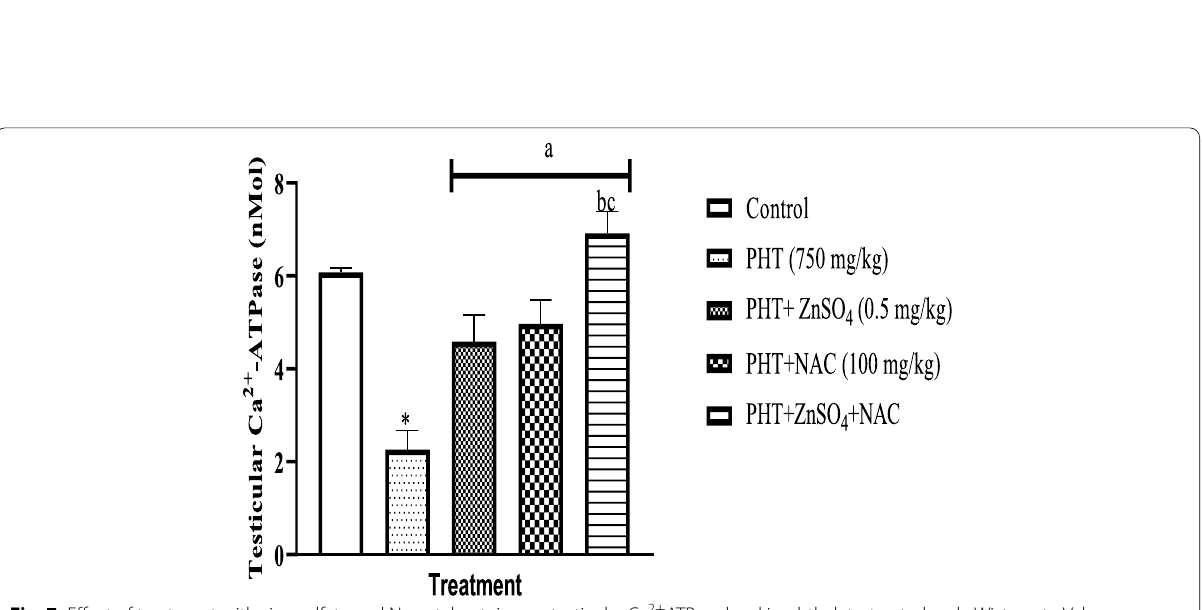
Fig. 7 Effect of treatment with zinc sulfate and N‑acetylcysteine on testicular Ca 2 + ATPase level in phthalate‑treated male Wistar rats. Values are expressed as mean SEM ( n 5) ( p < 0.05 ) (one‑way ANOVA followed by Tukey’s post hoc test). PHT phthalate, ZnSO 4 zinc sulfate, NAC ± = N‑acetylcysteine. *, a , b , and c were considered statistically significant ( p < 0.05) when compared with the control, PHT‑, PHT PHT NAC‑treated groups +